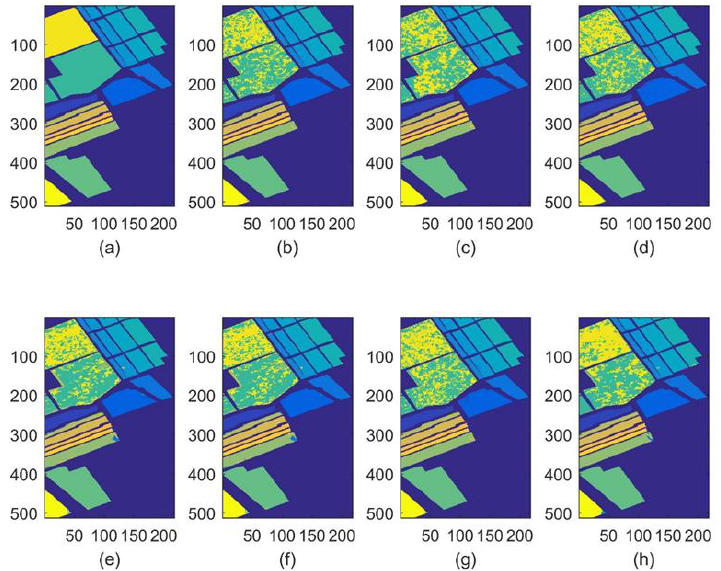
Figure 5. Classification maps for Salinas. ( a ) Ground truth, ( b ) BH, ( c ) LDFA, ( d ) LPP, ( e ) NWFE, ( f ) PCA, ( g ) SH, ( h ) the proposed SDHE. The different colors indicate the different classes.